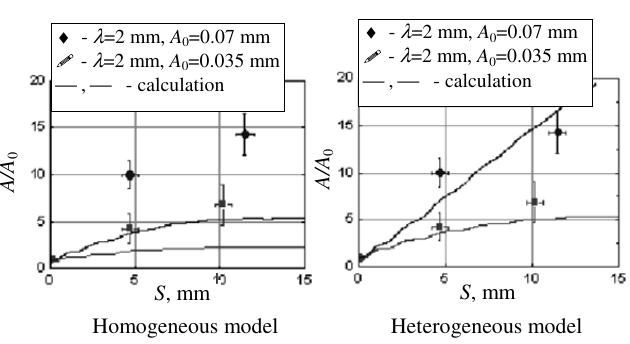
Fig. 5. Perturbation growth in copper sample. Experiment and